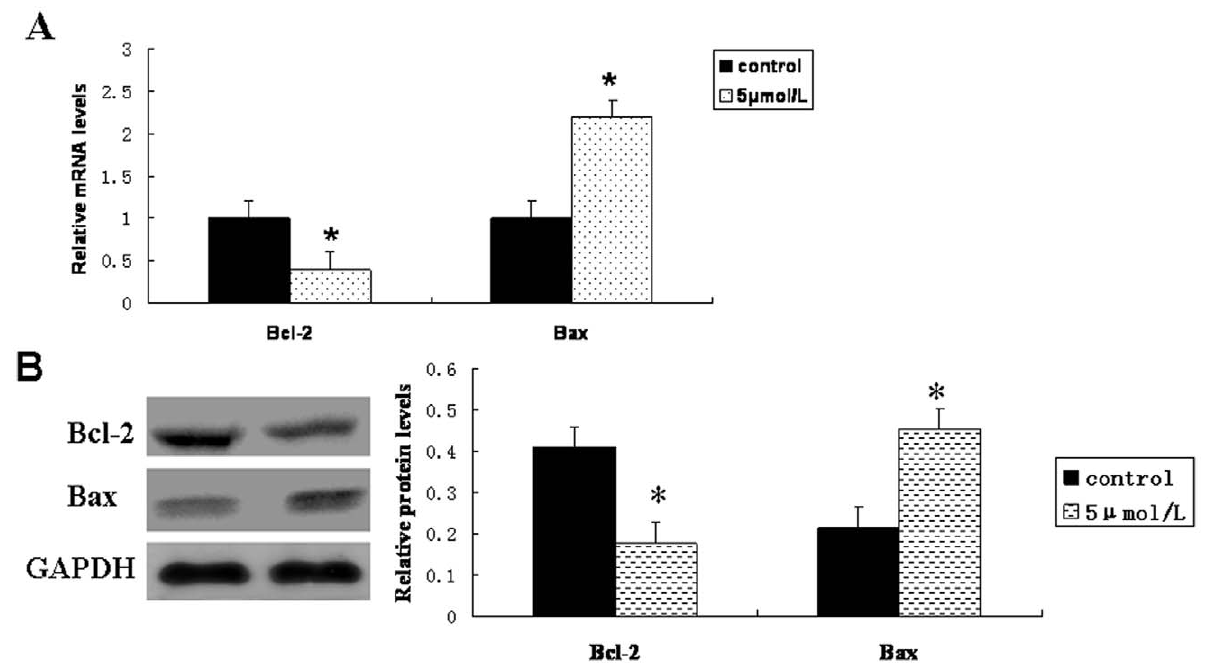
Figure 4. Effect of As2O3 on expression of STAT3 target genes Bcl-2 and Bax in FU97 cells. (A) Quantitative RT-PCR and (B) western blot analysis and quantification of cells treated with As 2 O 3 at 5 m mol/L for 72 h. The mRNA and protein expression of Bcl-2 was downregulated in As 2 O 3 treated cells, but that of Bax was upregulated. All experiments were performed in triplicates. * p , 0.05 compared with control. doi:10.1371/journal.pone.0054774.g004 Table 2. Association of clinicopathologic features with signal transducer and activator of transcription 3 (STAT3) expression in the primary tumor of alpha-fetoprotein (AFP)-positive and - negative gastric